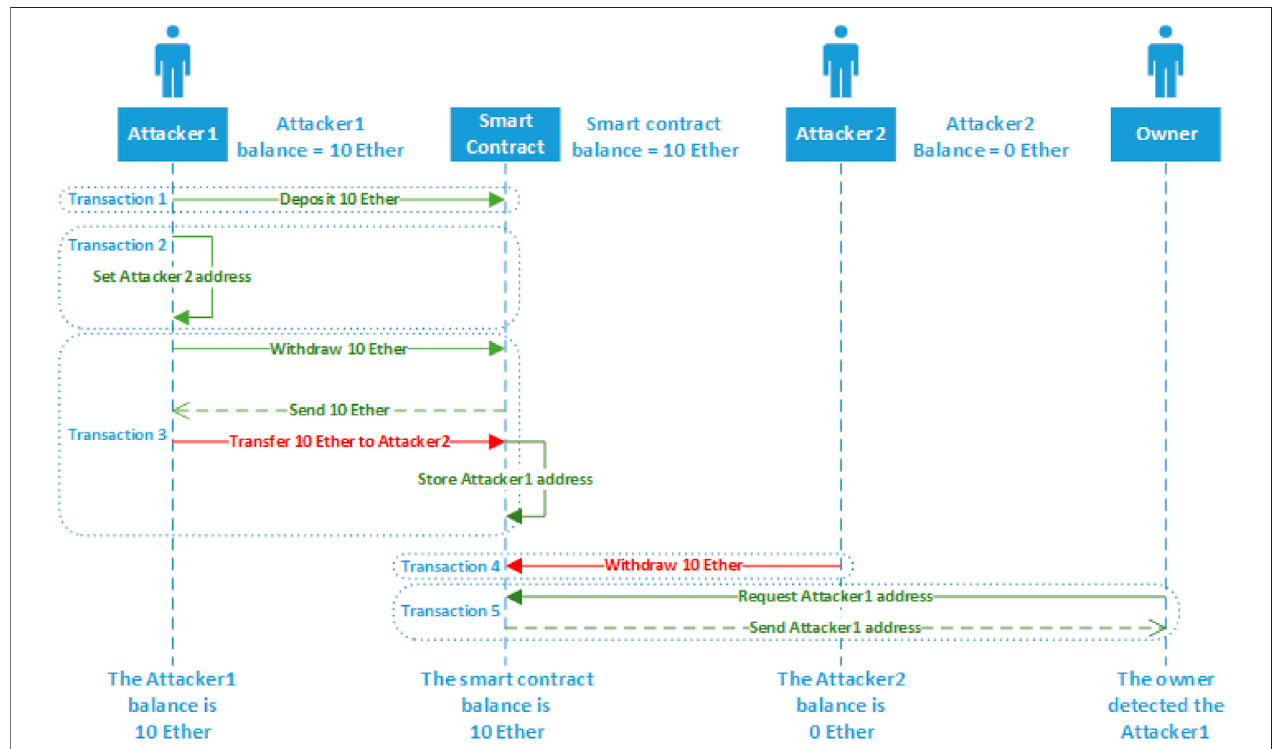
FIGURE 12 | UML sequence diagram for the second scenario in the second case